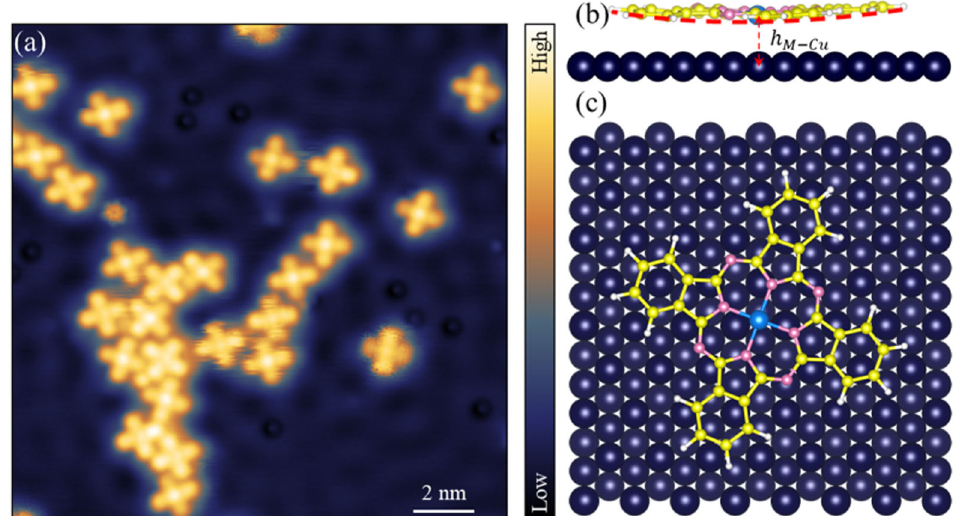
Fig. 1 | STM topography and schematic views of the adsorption geometry. a Low-magni fi cation STM image of FePc and CoPc molecules using a CO tip ( V =100mV, I =30pA). Schematic side ( b ) and top ( c ) views of the relaxed FePc moleculeadsorbedonaCu(111) substrate. The red dashed curve in b indicates the